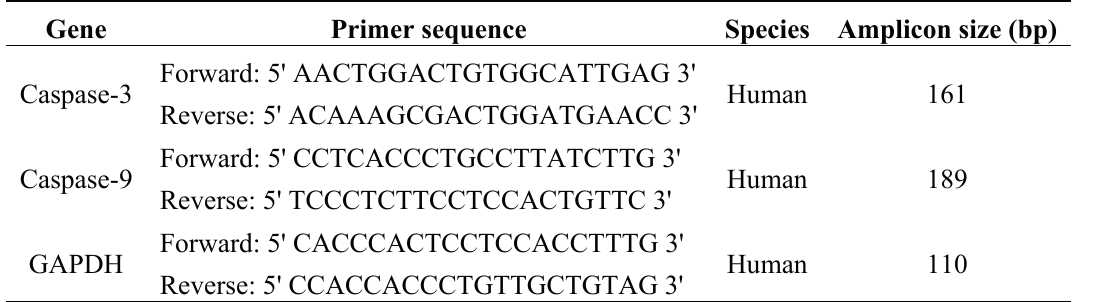
Table 1. Primers used in FQ-RT-PCR